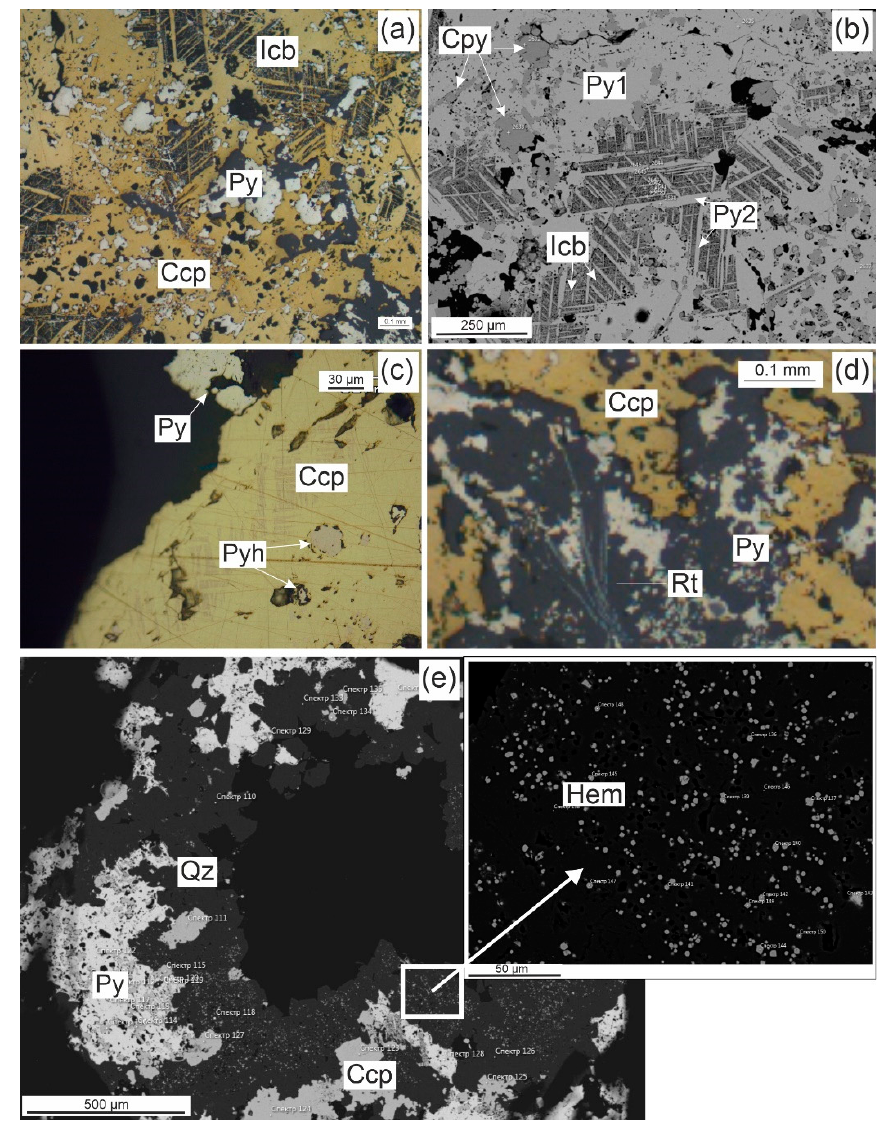
Figure 8. Chalcopyrite-pyrite layer in sample 242-2. ( a ) Lattice isocubanite in chalcopyrite grains (sample 242-2/2). ( b ) Porous pyrite (Py1) and lattice pyrite (Py2) formed after leached isocubanite. BSE image. ( c ) Lattice texture of exsolved isocubanite with chalcopyrite. Primary pyrrhotite in chalcopyrite around a void (sample 242-2). ( d ) Rutile in quartz (sample 242-2/1). ( e ) Hematite grains in quartz around a void. BSE image. Table 4. Average chemical composition of minerals from vein-disseminated